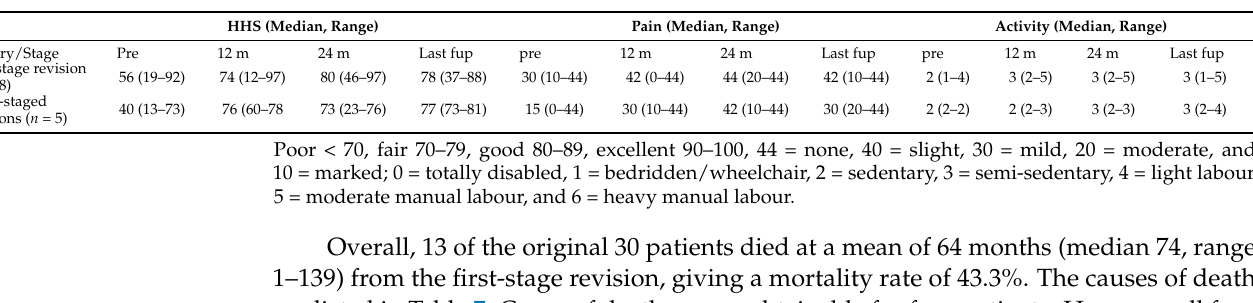
Table 6. Functional outcomes in patients undergoing two-stage or multi-staged revisions by time.